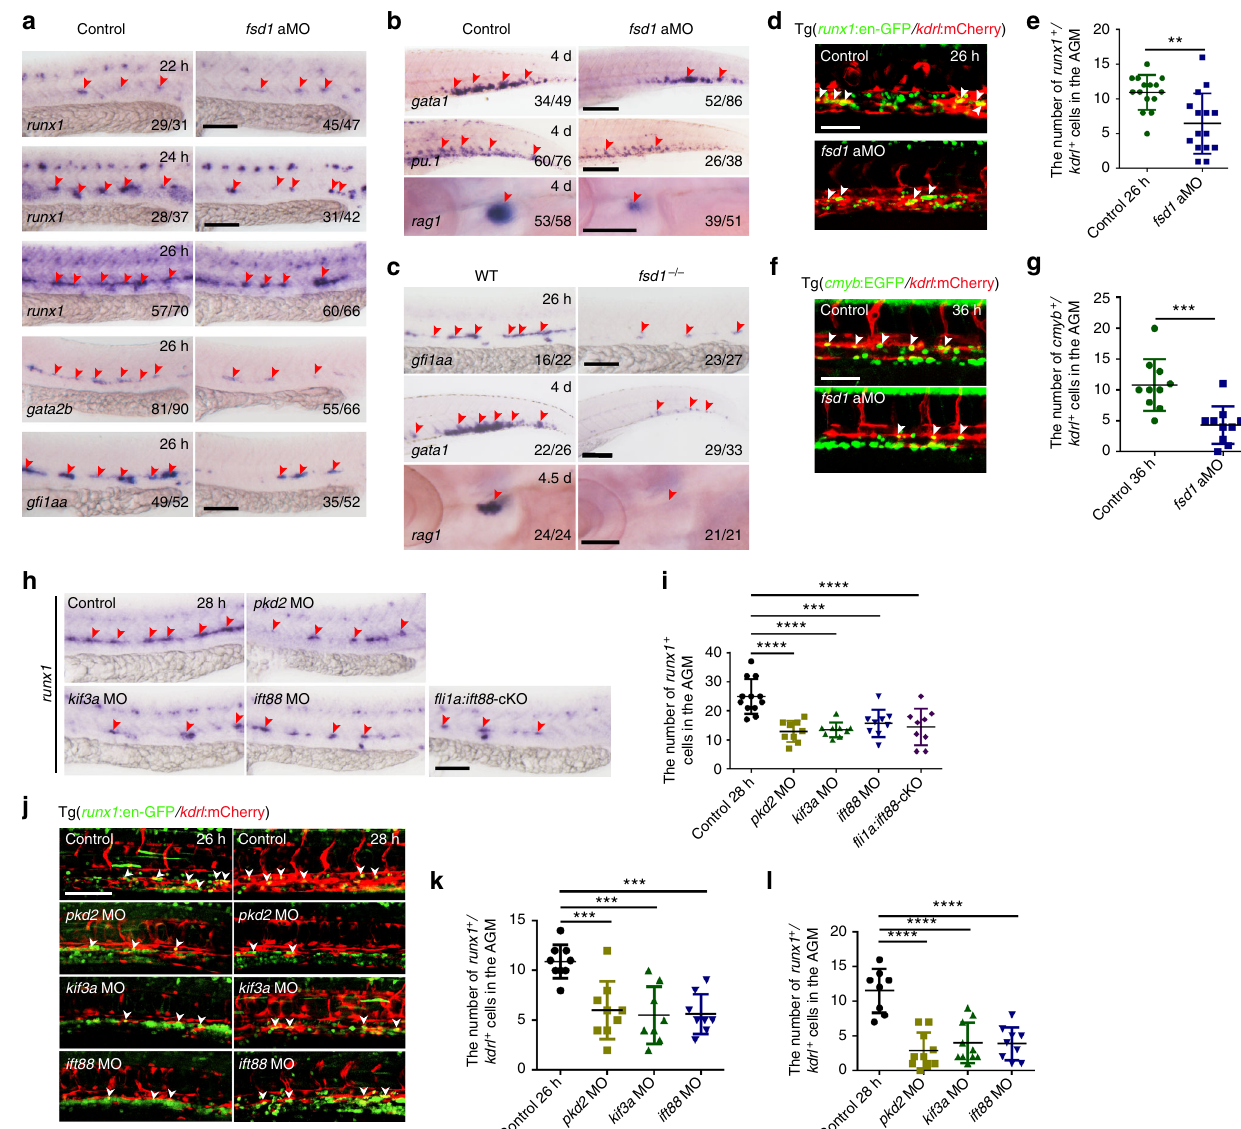
Fig. 5 Cilia are required for hemogenic endothelium (HE) speci fi cation. a Whole-mount in situ hybridization (WISH) analysis showing the expression of HE markers, runx1 , gata2b , and g fi 1aa , in the aorta-gonad-mesonephros (AGM) region at 22, 24, and 26 hpf. Red arrowheads denote the expression of HE markers. b Expression of erythroid marker ( gata1 ), myeloid marker ( pu.1 ) in the caudal hematopoietic tissue (CHT) and T cell marker ( rag1 ) in the thymus at 4 dpf. Red arrowheads mark the corresponding hematopoietic cells. c The expression of HE marker g fi 1aa , erythroid marker gata1 , and T cell marker rag1 in fsd1 − / − . Red arrowheads mark the corresponding hematopoietic cells. d , e The imaging of kdrl :mCherry + / runx1 :en-GFP + HE cells (white arrowheads) in the AGM region in control and fsd1 morphants with quanti fi cation ( e ) at 26 hpf. Error bars, mean ± s.d., n = 15 embryos. ** P < 0.01, Student ’ s t -test. f Confocal imaging of HE cells ( kdrl :mCherry + / cmyb: EGFP + ) in control and fsd1 morphants at 36 hpf. White arrowheads denote HE cells. g The quanti fi cation of kdrl :mCherry + / cmyb: EGFP + HE cells in control and fsd1 morphants at 36 hpf. Error bars, mean ± s.d., n = 10 embryos. *** P < 0.001, Student ’ s t -test. h , i Representative images of runx1 expression (red arrowheads) in control and cilia-impaired embryos with quanti fi cation ( i ) at 28 hpf. Red arrowheads denote runx1 + cells in the AGM region. j – l High-resolution imaging of HE cells ( kdrl :mCherry + / runx1 :en-GFP + ) in control and cilia-impaired embryos with quanti fi cation ( k , l ). White arrowheads indicate kdrl :mCherry + / runx1 :en-GFP + cells in the AGM region. Data represent the analysis results of one-way ANOVA – Dunnett test. Error bars, mean ± s.d., n = 12, 9, 9, 9, 9 embryos ( i ). n = 9, 9, 8, 8 embryos ( k ). n = 8, 10, 10, 9 embryos ( l ). *** P < 0.001, **** P < 0.0001. Scale bars, 100 µ